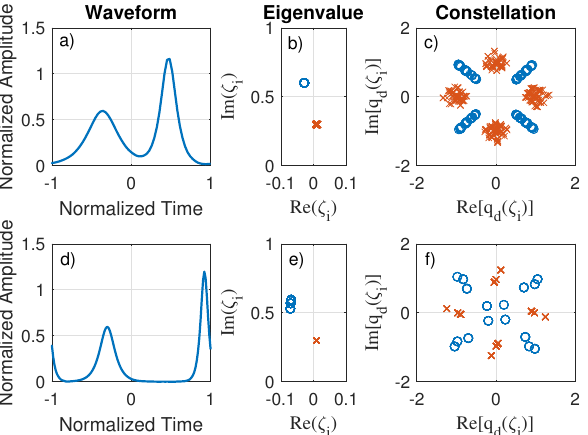
Figure 8. Simulation with the Raman effect at 1600 km of propagation distance with 9 dBm of launch power. ( a – c ) Results for the symbol period T S1 . ( d – f ) Results for the symbol period T S2 . ( a , d ) Received waveform for one symbol of the sequence. ( b , e ) Received eigenvalues. ( c , f ) Normalized received spectral function constellations, q d ( ζ 1 ) (blue circles) and q d ( ζ 2 ) (red crosses).